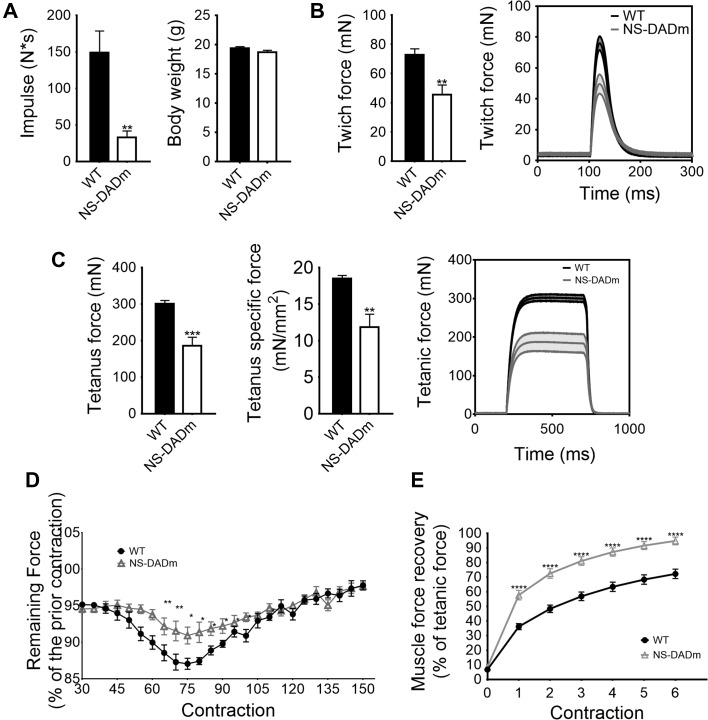
Contractile physiology of NS-DADm skeletal muscles. (A) Four-limb hanging test of 2-month-old WT and NS-DADm mice (n = 6–8). Holding impulse was calculated as the longest hanging time multiplied by the body weight. (B and C) Muscle force generation in EDL muscles isolated from 4-month-old female mice in ex vivo twitch contractions or tetanus contractions (n = 4 mice). The specific force was calculated by dividing the tetanic absolute force with muscle CSA. Average traces of the ex vivo twitch and tetanic contractions were shown with the shaded area as SEM. (D) Muscle fatigue was induced by repetitive stimulation. The fatigue index was expressed as the percentage of force left for every five contractions. (E) Force recovery after exhaustion (n = 4 mice). Data are presented as mean ± SEM. *P < 0.05, **P < 0.01, ***P < 0.001, ****P < 0.0001 between genotypes by unpaired t-test.